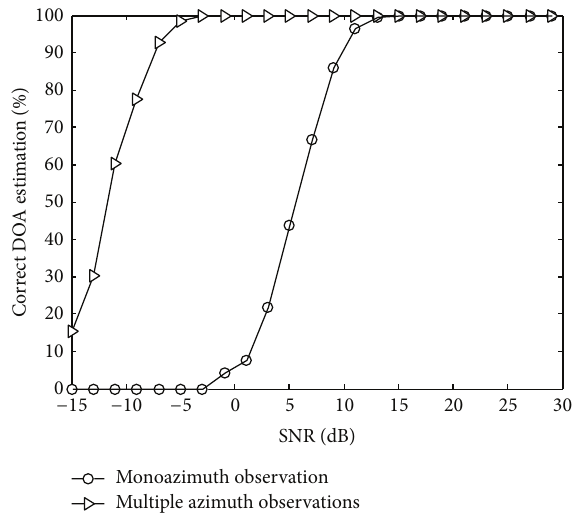
Figure 4: Angular displacement in the presence of topographic height.